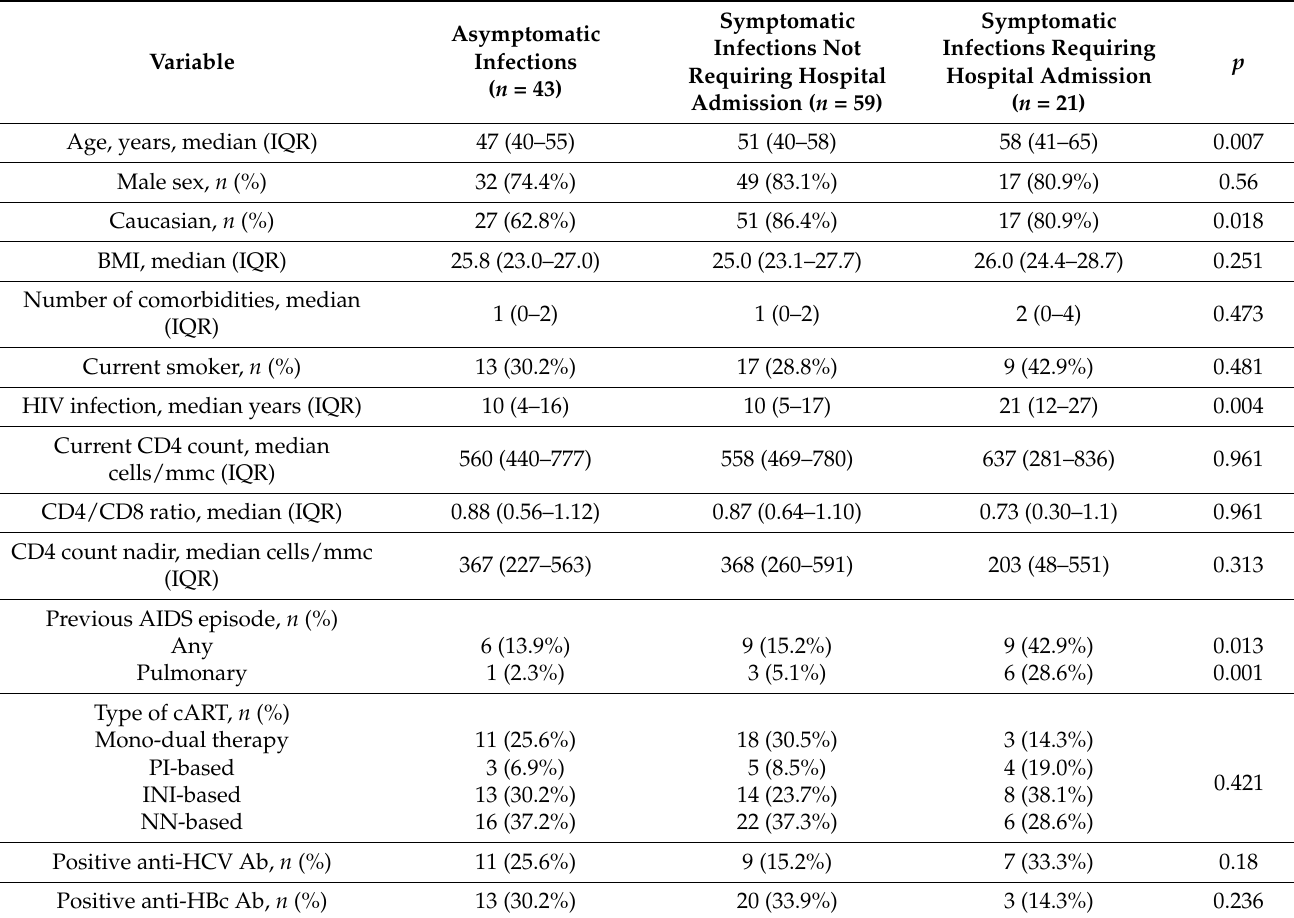
Table 1. Comparison of baseline demographic, clinical, and HIV-related parameters grouped accord- ing to COVID-19